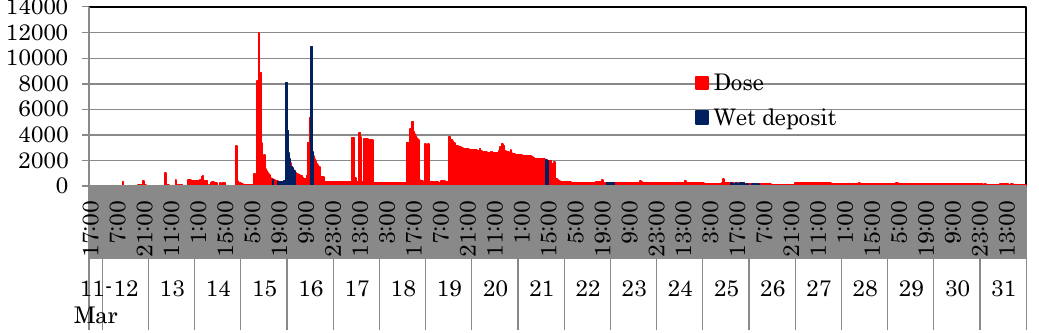
Figure 13. A time series of spatial dose (unit: μSv/h) and the ratio of dry and wet